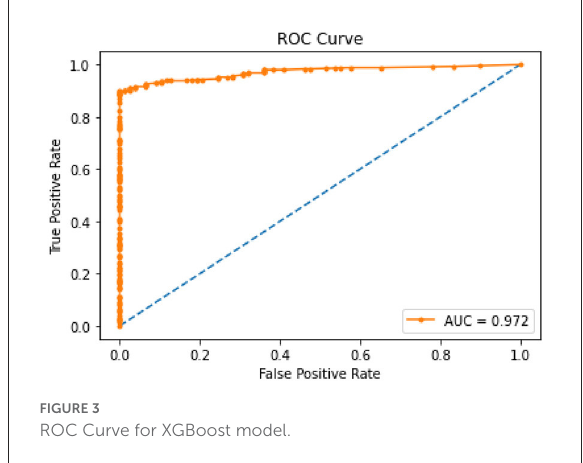
TABLE 6 Classification report for final model.